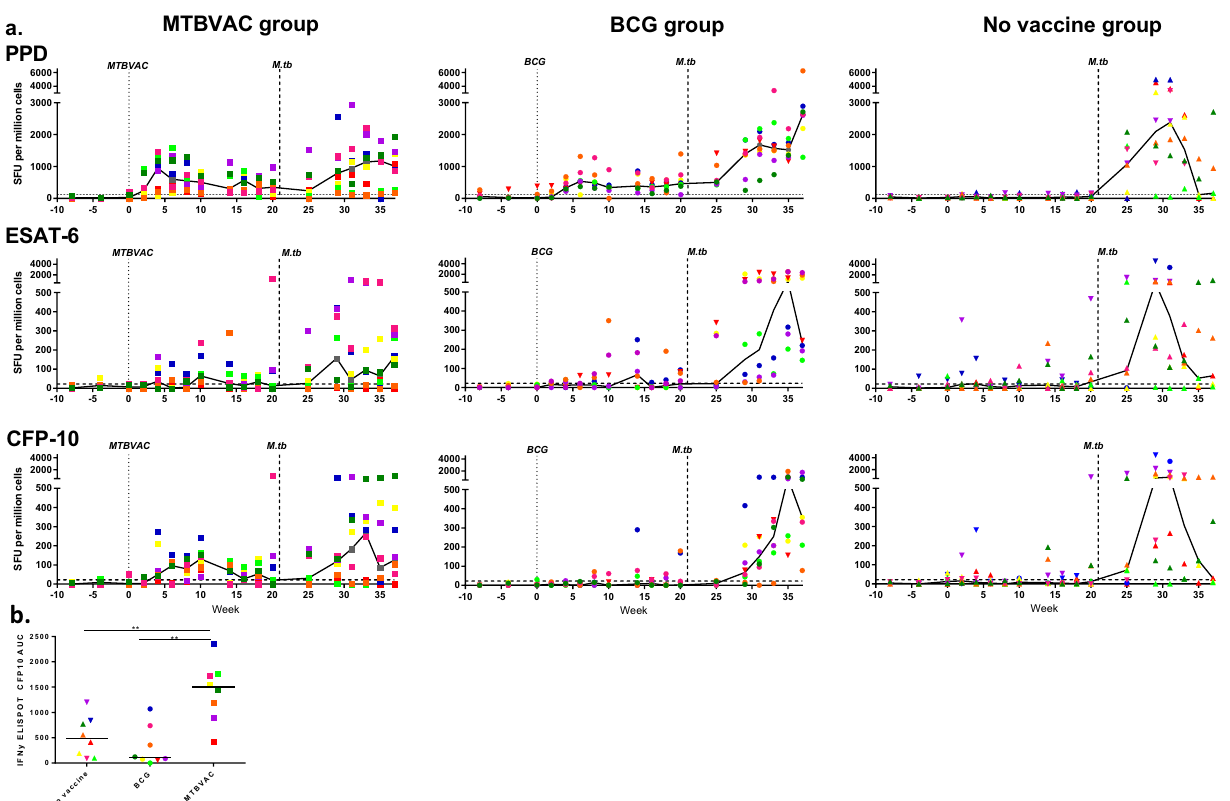
Fig. 3 Immune response to vaccination and challenge. The frequency of M. tuberculosis antigen-speci fi c IFN- γ -secreting cells induced following BCG vaccination and challenge measured by ELISpot ( a ). Top row: PPD-speci fi c response pro fi les, middle row: ESAT6-speci fi c response pro fi les, bottom row: CFP10-speci fi c response pro fi les. Left: response pro fi les in the MTBVAC-vaccinated group; middle: response pro fi les in the BCG-vaccinated group; right: response pro fi les in the unvaccinated group. Vaccination with MTBVAC, or BCG indicated by the dotted line, and aerosol exposure to M. tuberculosis indicated by the dashed line at week 21. Comparison of the CFP10 - speci fi c IFN- γ response measured by ELISpot induced following vaccination with BCG or MTBVAC determined by analysis of the area under the response curve between week 2 and 20 after vaccination with group comparison made using Mann – Whitney between groups ** P ≤ 0.005 ( b ). All line graphs show individual response (circular symbol) and Group median response (solid line). The colour and symbol coding per individual is consistent throughout and between fi gures. Upside down triangular symbols indicate animals in which disease progressed to meet humane endpoint criteria. The assay threshold (mean of pre-vaccination values plus 1.5× standard deviation) is indicated by a horizontal dotted line (PPD: 119 spot forming units (SFU) per million cells; ESAT6: 40 SFU per million cells; CFP10: 28 SFU per million